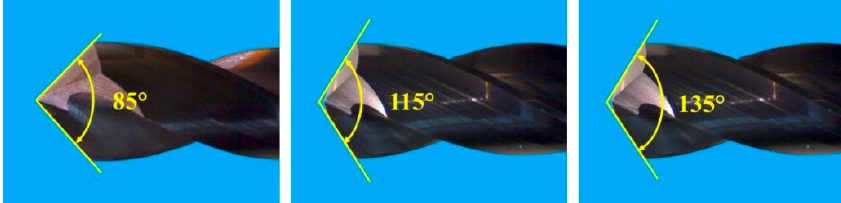
Figure 13. Drill bit point angles